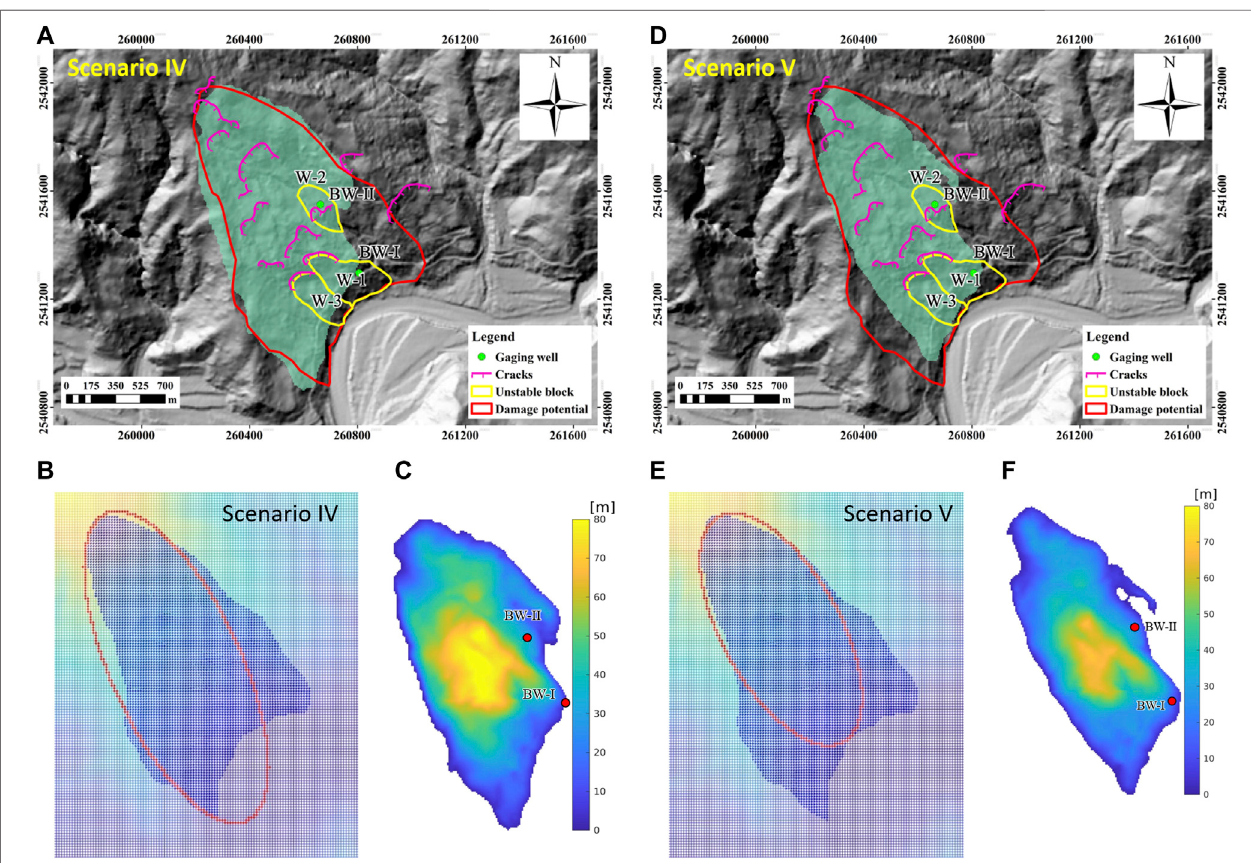
FIGURE 8 | Scenarios IV and V (Taitung-Yanpin-T003). (A,D) The covered area by the computed ICS (shaded in jade-green), the delineated landslide-prone area (red contour), and the locations of gaging wells (BW-I and BW-II). (B,E) The delineated landslide-prone area (blue shade) and the reference ellipse (red outlined) for constructing the most appropriate ICS. (C,F) Depth distribution of the released mass with respect to the ICS.